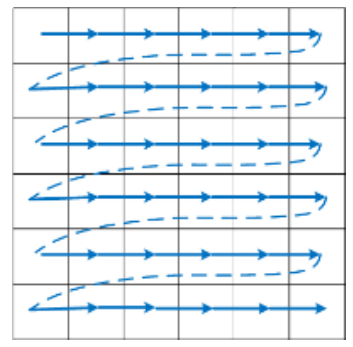
Figure 4. Route of byte rearrangement.